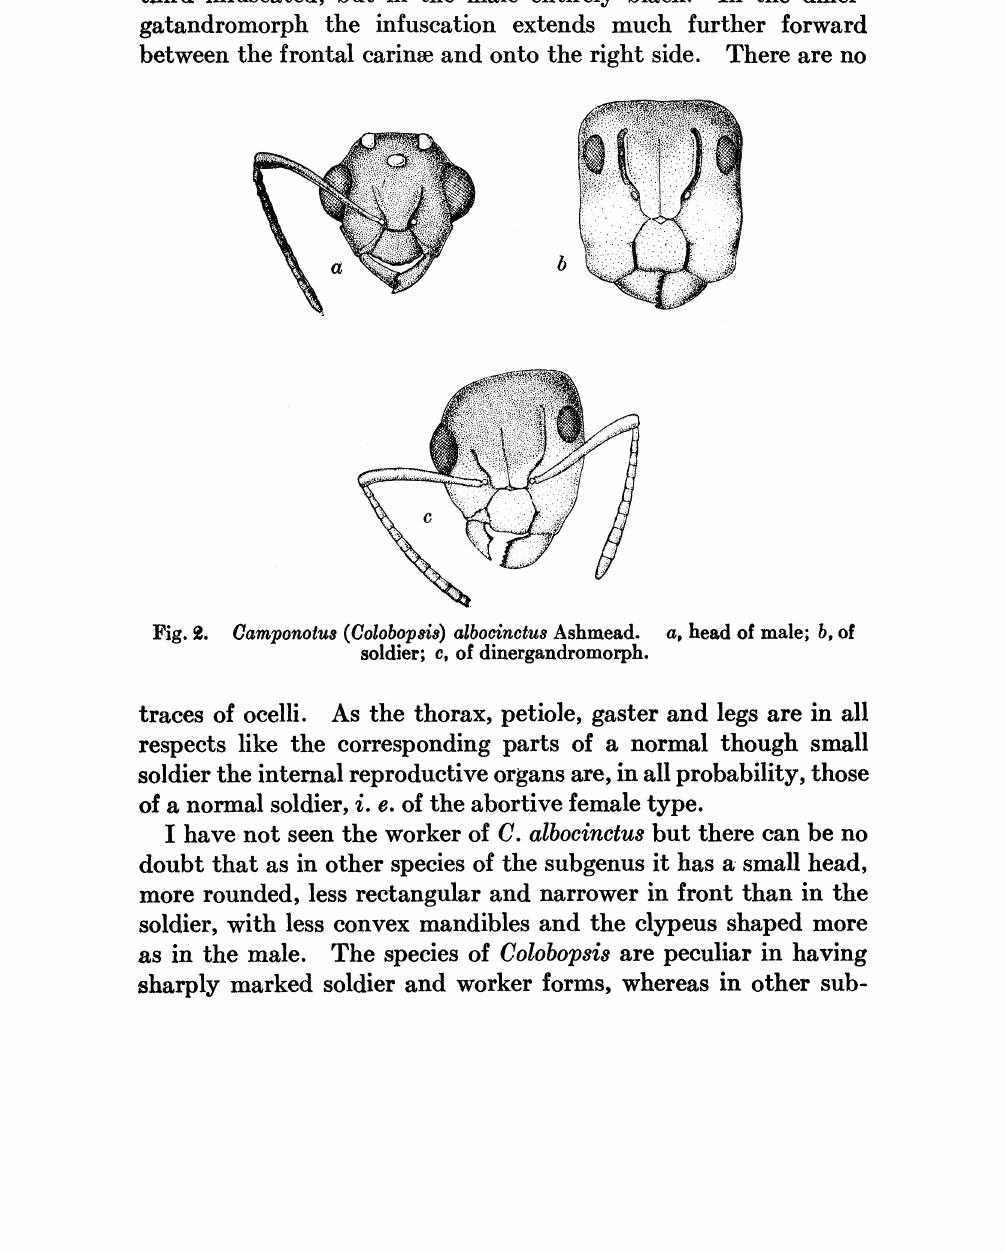
Fig. 2. C, amponolus (Colobopsis) albocinctus Ashmead. a, head of male; b, of soldier; c, of